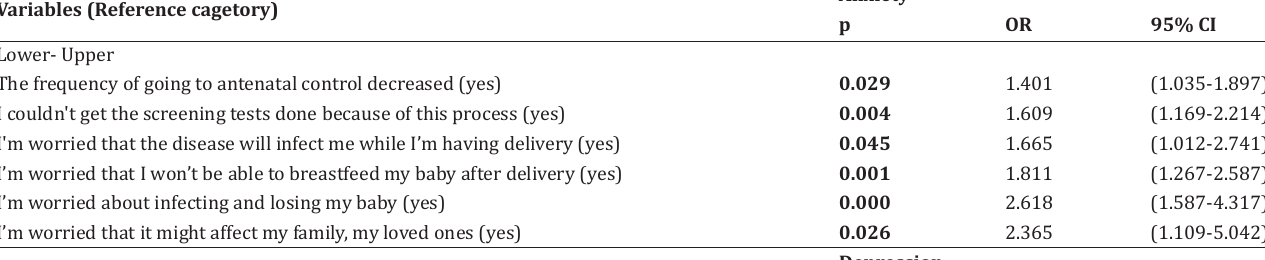
Table 5 Evaluation of factors affecting anxiety and depression levels with regression analysis Variables (Reference